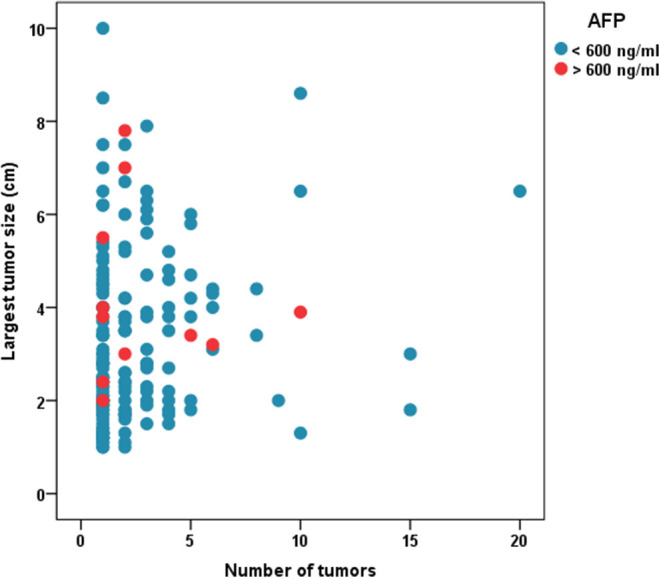
Distribution of tumor size and number in patients who underwent LDLT.